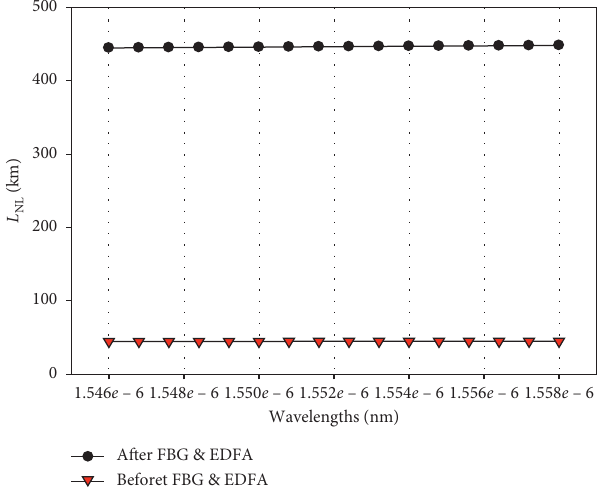
Figure 8: Variation of L NL at different values of wavelengths.